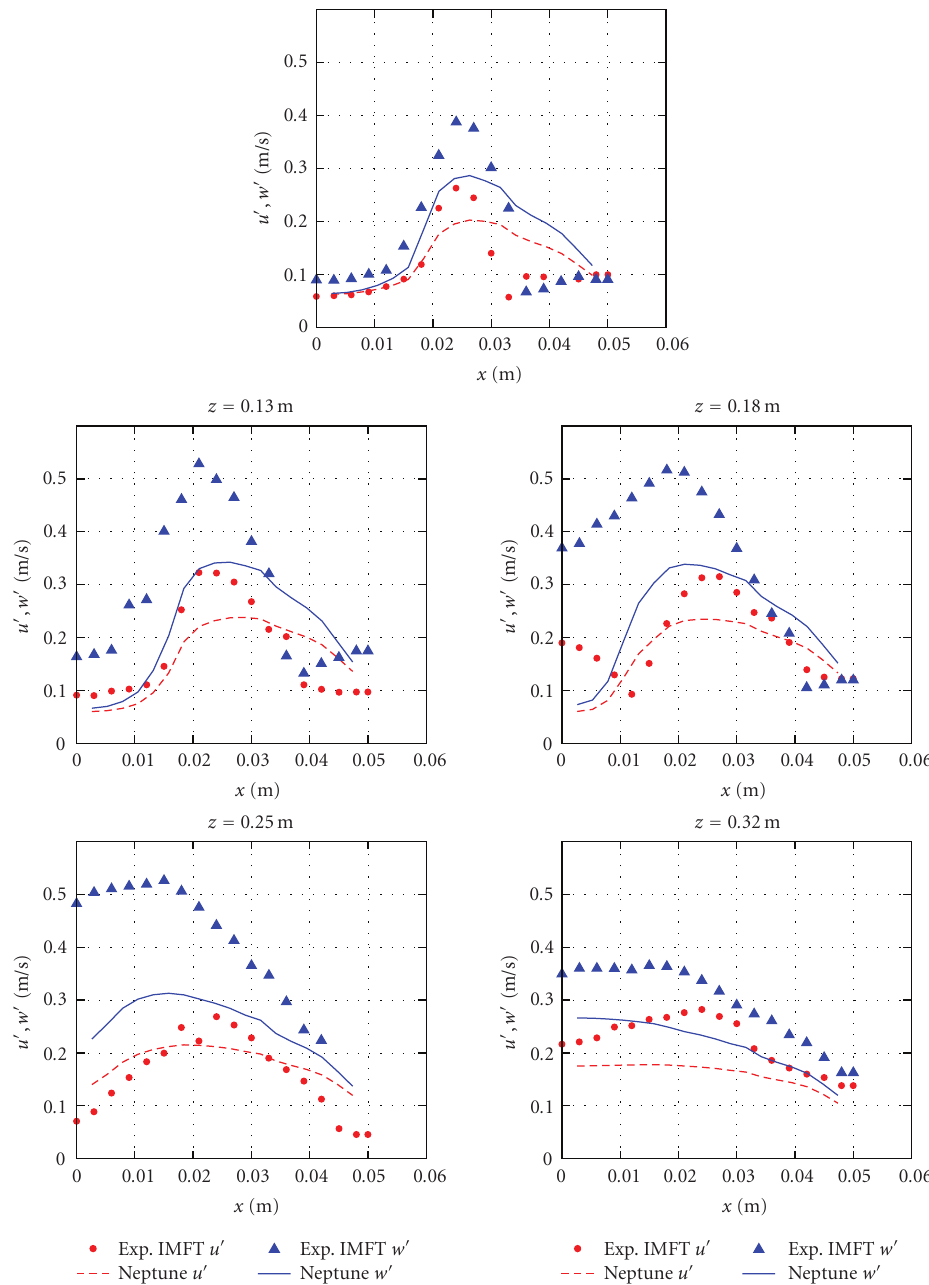
Figure 8: Liquid r.m.s. radial ( u (cid:4) ) and axial ( w (cid:4) ) velocity profiles ( R ij - ε